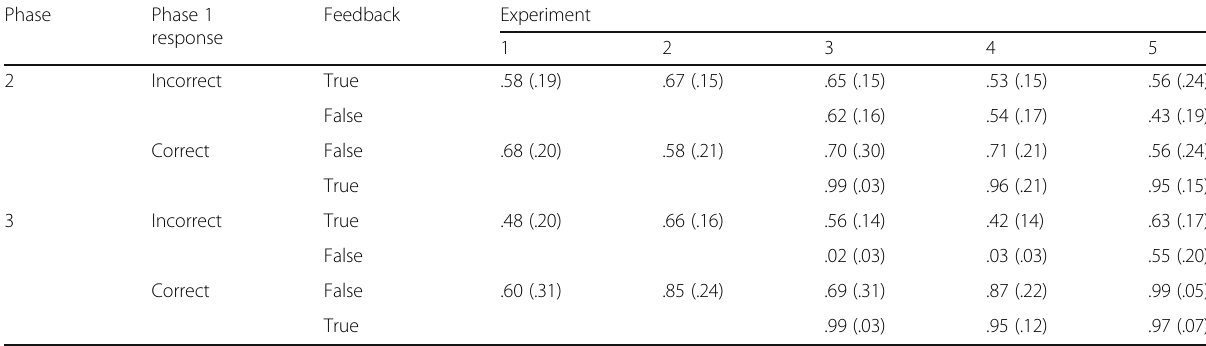
Table 1 Proportion of correct recall by phase depending on whether the given answer in Phase 1 was correct or incorrect and whether the feedback given to the response was true or